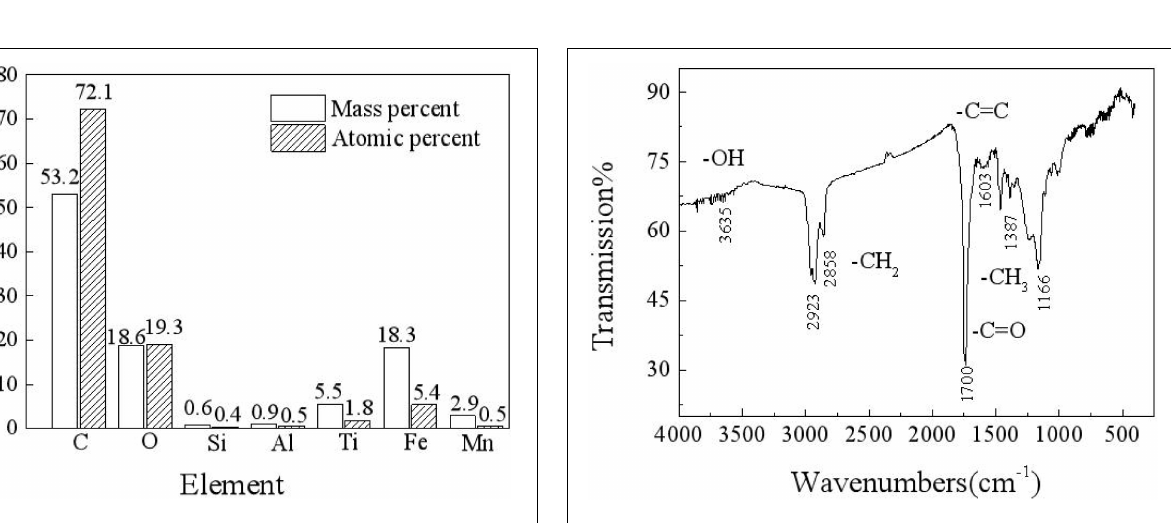
FIGURE 2 | Diagram of composition of carbon deposition. FIGURE 3 | Infrared spectrum of a carbon